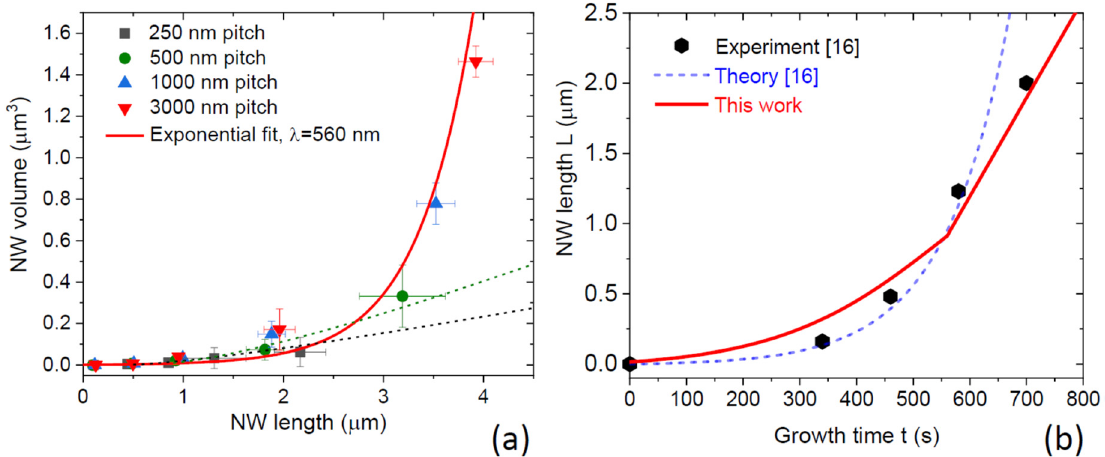
Figure 7. ( a ) NW volume versus length for catalyst-free SAG InAs NWs grown by MBE at 480 °C in regular square arrays of patterned holes in SiO 2 /Si(111). Symbols represent the data of Ref. [20]; NW radii at different data points are summarized in Table 3. Bold line shows exponential fit obtained from Equation (19) with 𝜆 = 560 nm. Dashed lines show the curves obtained with the shadowing effect for 𝑃 = 250 nm and 500 nm. ( b ) Length of an Au-catalyzed, 12 nm radius InP NW versus the growth time: symbols represent the data of Ref. [16], dashed line shows the modeling results [16], bold line is the fit obtained from Equations (10) to (13) with 𝑃 = 200 nm.